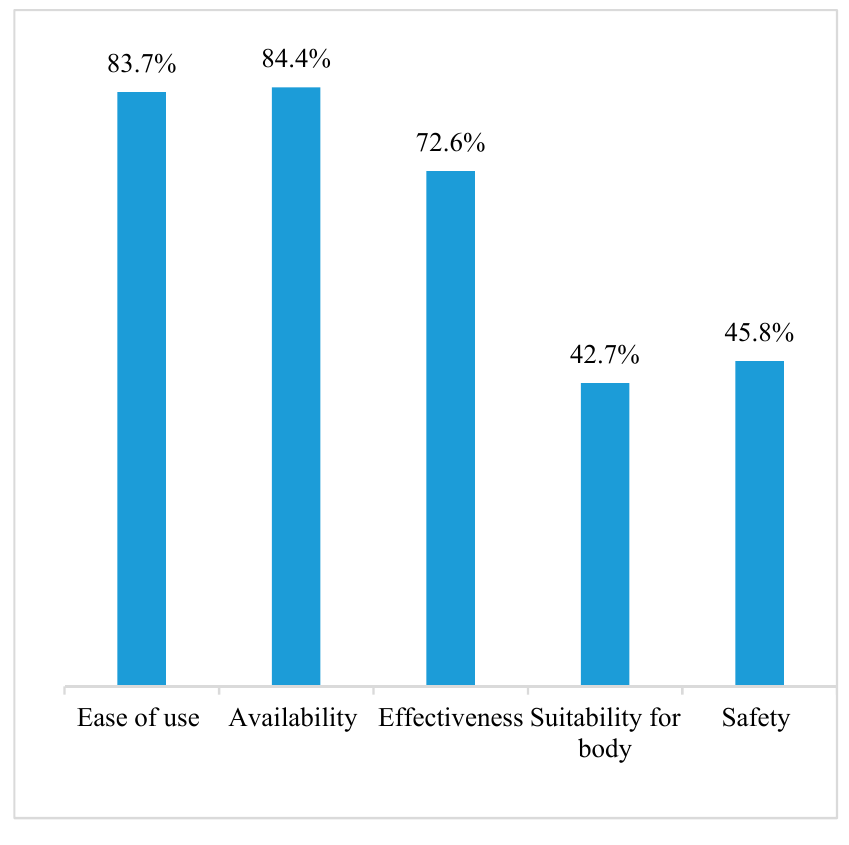
Figure 2. Reasons for preferring OCP.